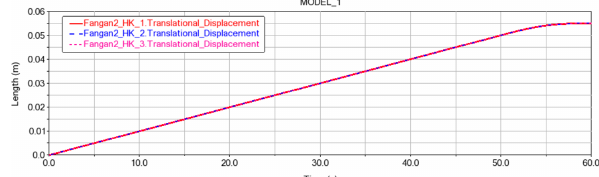
Figure 22. Displacement curves of three sliders – based on the sec- ond design scheme.